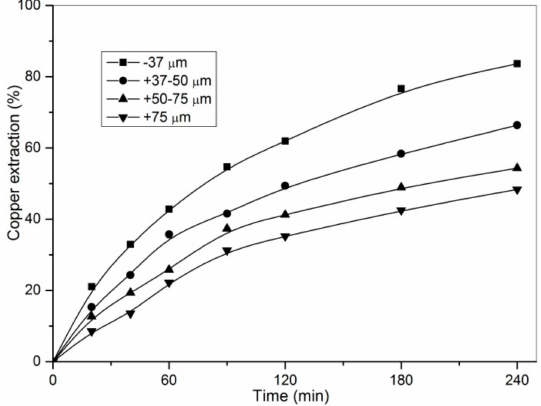
Figure 3. Influence of the particle size on the copper extraction yield (temperature—40 ◦